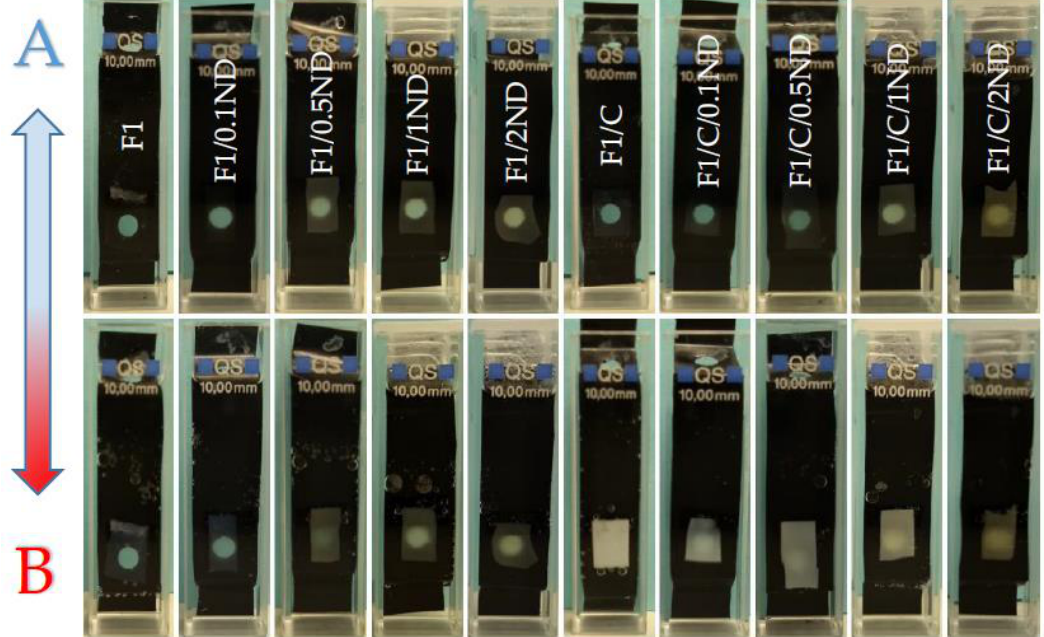
Figure 8. Phase transition of the films visualized as follows: ( A ) room temperature samples and ( B ) heated samples. Heat-cool-heat cycle (Figure S9, Supplementary Materials).